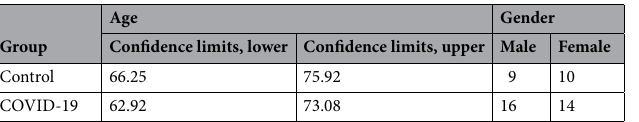
Table 1. Patient characteristics in two cohorts showing matching in terms of age and